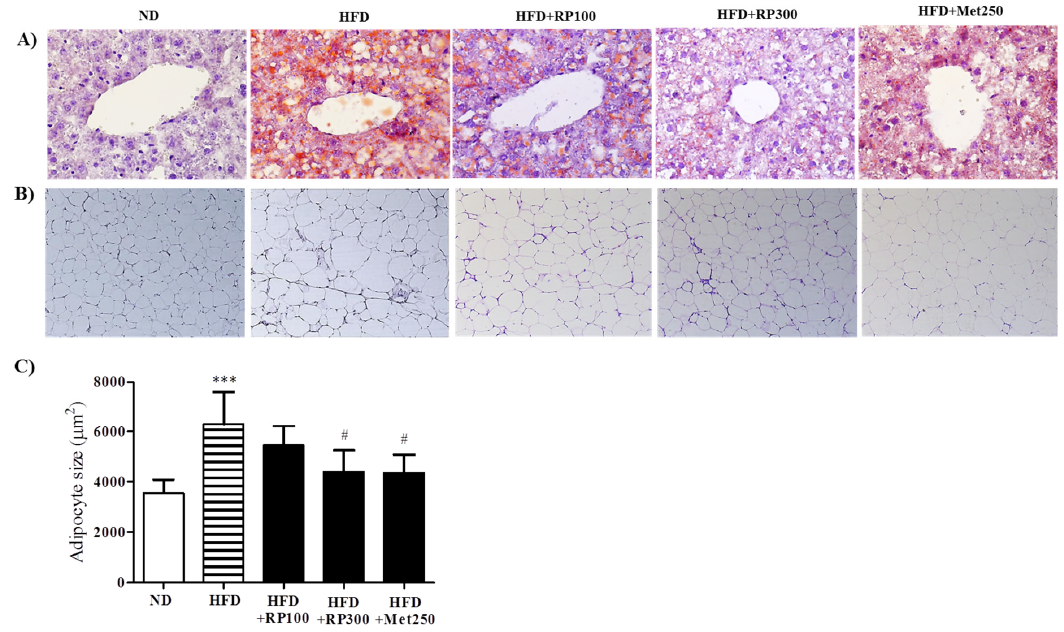
Figure 3. Effects of RP extract on lipid accumulations in livers and adipose tissues. ( A ) Oil red